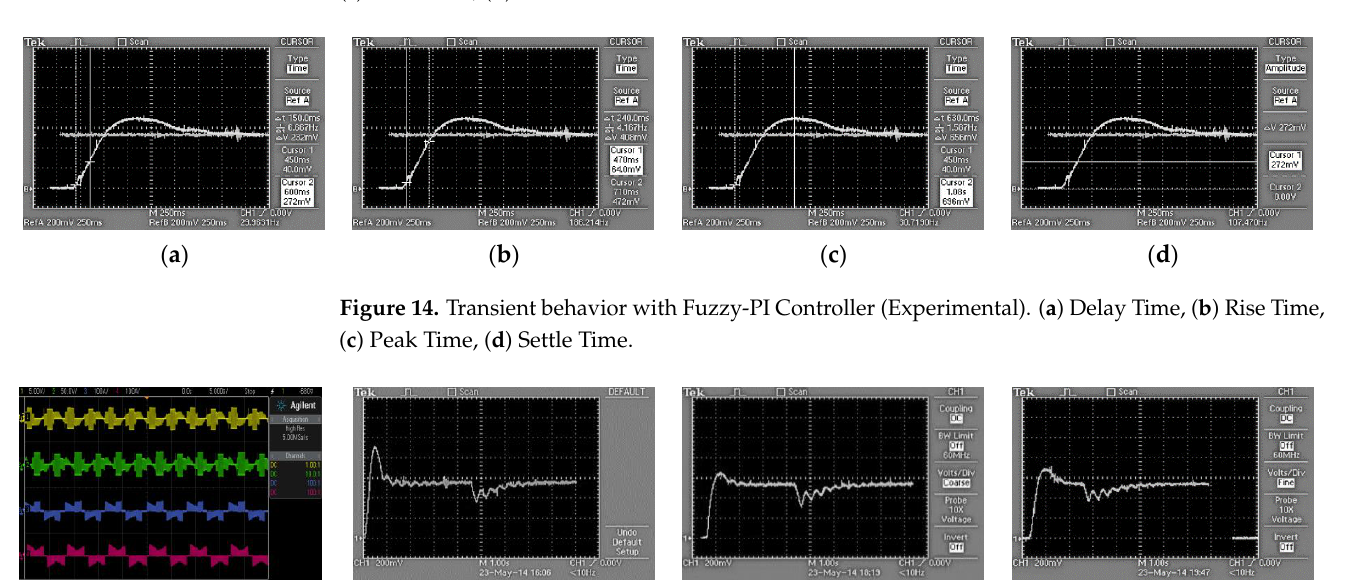
Figure 13. Transient behavior with Fuzzy Controller (Experimental). ( a ) Delay Time, ( b ) Rise Time, ( c ) Peak Time, ( d ) Settle Time.